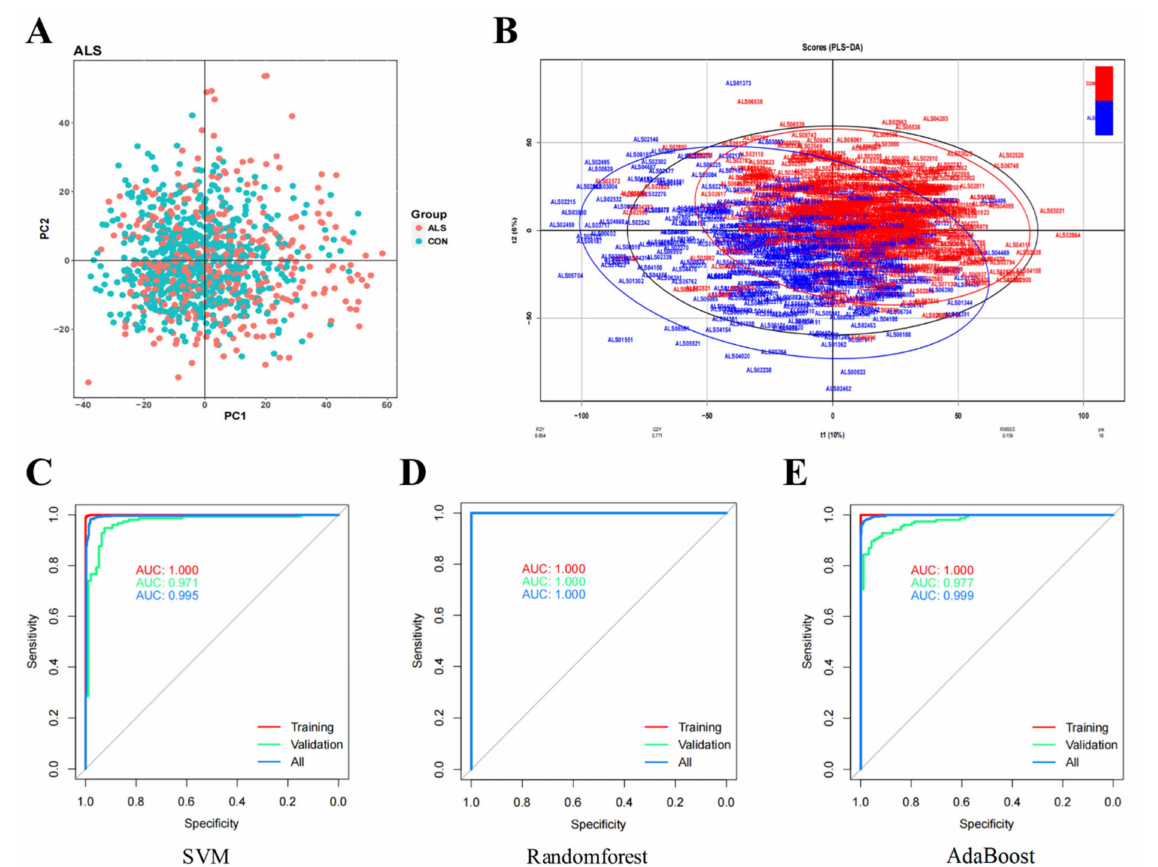
Figure 10. Screening for prognostic markers in amyotrophic lateral sclerosis and model evaluation. ( A ) Principal component analysis. ( B ) Partial least squares discriminant analysis. ( C – E ) Receiver operating characteristic (ROC) curves of three classifiers. The three lines represent three datasets (Training, Validation, All), respectively. Area under the curve (AUC) value reflects the ability of the classifier to correctly sort the